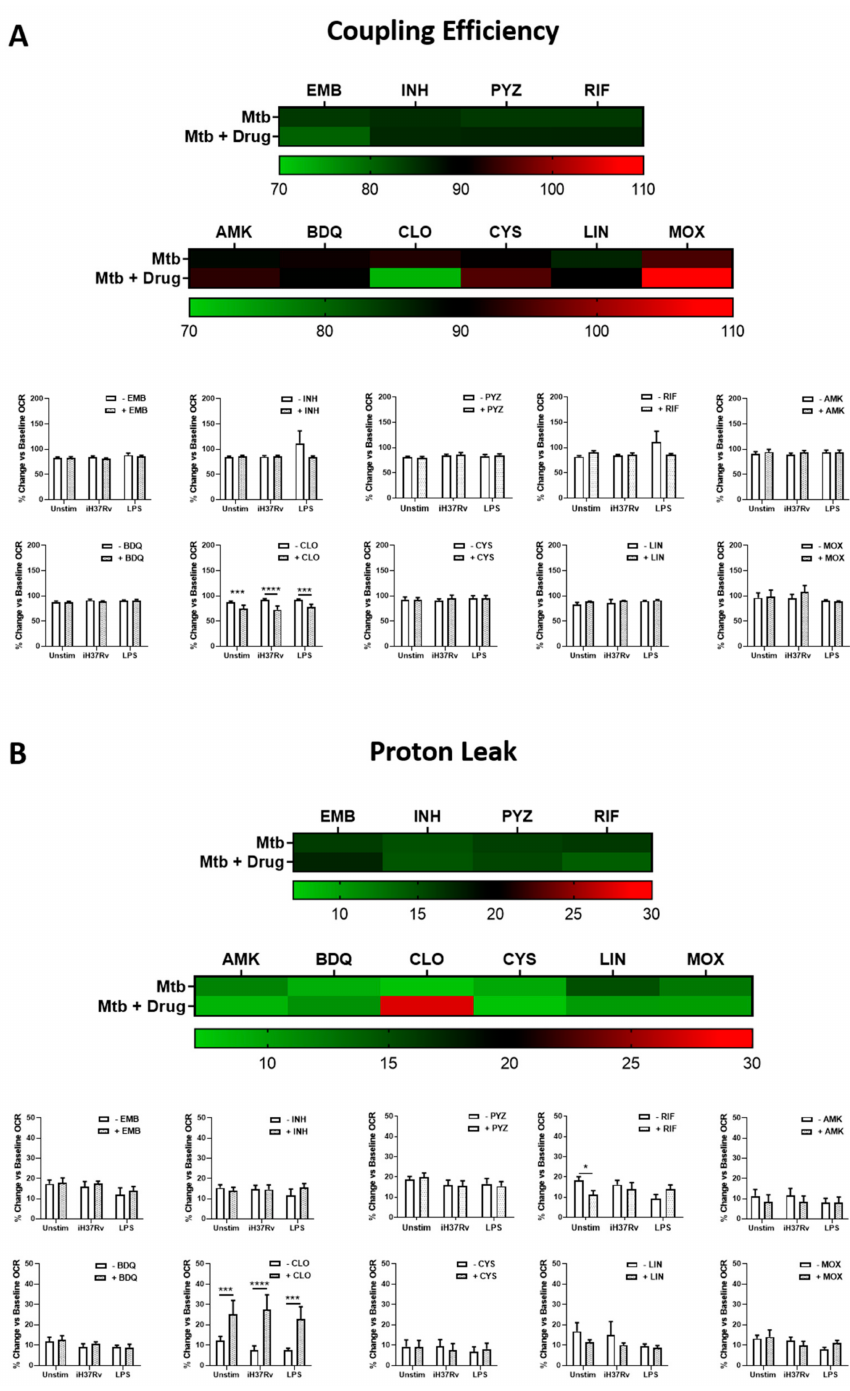
Figure 5. Clofazimine reduces mitochondrial coupling efficiency and increases mitochondrial proton leak in iH37Rv- Mtb-stimulated hMDMs. hMDMs, differentiated from PBMCs isolated from healthy blood donors, were treated with ethambutol (5 µ g/mL), isoniazid (1 µ g/mL), pyrazinamide (2 µ g/mL), rifampicin (2 µ g/mL), amikacin (5 µ g/mL), bedaquiline (5 µ g/mL), clofazimine (2 µ g/mL), cycloserine (5 µ g/mL), linezolid (15 µ g/mL) or moxifloxacin (12.5 µ g/mL) three hours post stimulation with either iH37Rv-Mtb or LPS (100 ng/mL). 24 h post stimulation, ( A ) mitochondrial coupling efficiency and ( B ) mitochondrial proton leak were determined using the Seahorse Extracellular Flux Analyser. Bars denote mean ± SEM * p < 0.05 (Two-way repeated measures ANOVA with Sidak’s multiple comparisons test). Ethambutol (EMB, n = 7); isoniazid (INH, n = 8); pyrazinamide (PYZ, n = 7); rifampicin (RIF, n = 9); amikacin (AMK, n = 5); bedaquiline (BDQ, n = 6); clofazimine (CLO, n = 6); cycloserine (CYS, n = 4); linezolid (LIN, n = 8); moxifloxacin (MOX, n =